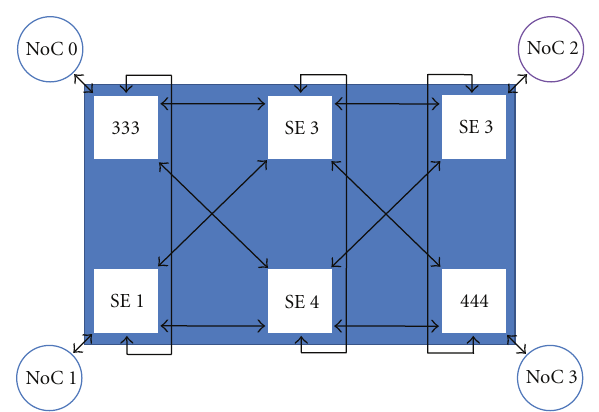
Figure 20: The simulation state of NiP-HXN model at first step of worst case.